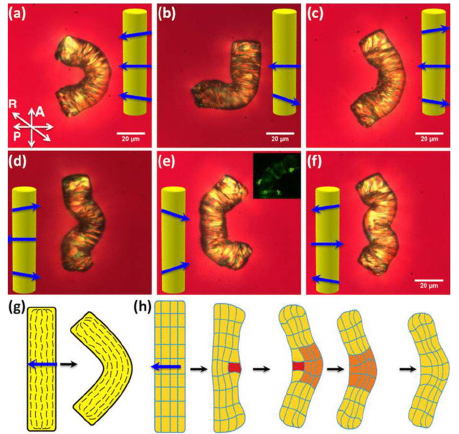
Figure 14. ( a – f ) Examples of reversible morphing of LCE micro-particles including gold nanoparticles, shaped by means of unidirectional laser-beam scanning along the blue arrows. The inset in ( e ) shows a typical coherent anti-Stokes Raman scattering polarizing microscopy image of an LCE gold-nanoparticle-doped micro-particle that was bent using a scanning laser beam. ( g ) Scheme of director distributions in the LCE micro-particle during the bending induced by the laser beam. ( h ) Scheme showing the effect of local manipulation of LCE orientational ordering by a scanned laser beam along the direction marked by the blue arrow. The scanning causes nonreciprocal unidirectional motion of a molten region (red), and a modification of the LCE polymeric network in the vicinity of the “hot” scanning region (orange), eventually leading to the stable modification of the particle shape, persisting after the laser is turned off. Reproduced with permission from the authors of [66].